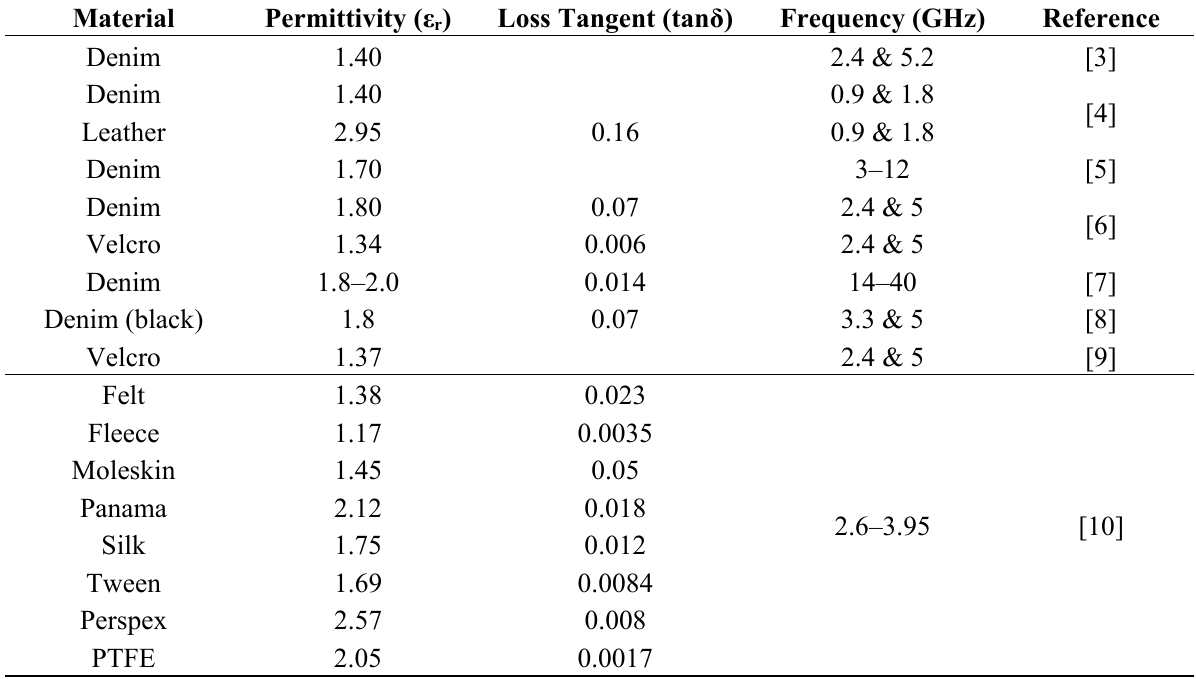
Table 1. Substrates’ dielectric